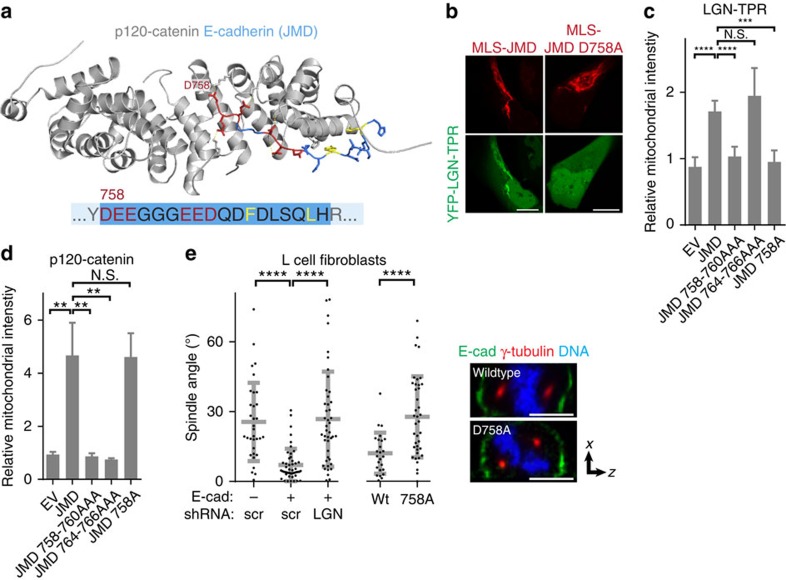
E-cadherin-induced spindle orientation is dependent on LGN binding.(a) Three-dimensional structure of the interaction between p120-catenin and the juxtamembrane domain (JMD) of E-cadherin, indicating the two negatively charged triplets (red) and hydrophobic residues (yellow) within E-cadherin that contribute to p120-catenin binding; based on ref. 33. (b,c) Recruitment of YFP–LGN–TPR to wild-type or D758A JMD, which was targeted to mitochondria by fusion with the mitochondrial localization signal (MLS) of ActA. The quantification shows the ratio of mitochondrial versus cytosolic YFP–LGN–TRP on co-expression of empty vector (EV), wild-type JMD or the indicated mutants; n=5. (d) Quantification of the recruitment of GFP-p120-catenin to JMD, containing indicated point mutations, and targeted to mitochondria by fusion with the MLS of ActA; n=5. (e) Quantification of mitotic spindle angle relative to the basal surface of parental L-cells, L-cells-expressing E-cadherin with either scrambled (scr) or LGN shRNAs, or L-cells-expressing wild-type or D758A E-cadherin-GFP, pooled from three independent experiments. Right: xz-projection of mitotic cell showing similar lateral distribution at cell–cell contacts of wild-type and D758A E-cadherin-GFP. Quantified data were pooled from three independent experiments, grey bars in dot plots show mean±s.d. Scale bars, 5 μm. **P<0.003, ***P<0.0002, ****P<0.0001, N.S.=not significant using unpaired student t-test (c,d) or Mann–Whitney test (e).